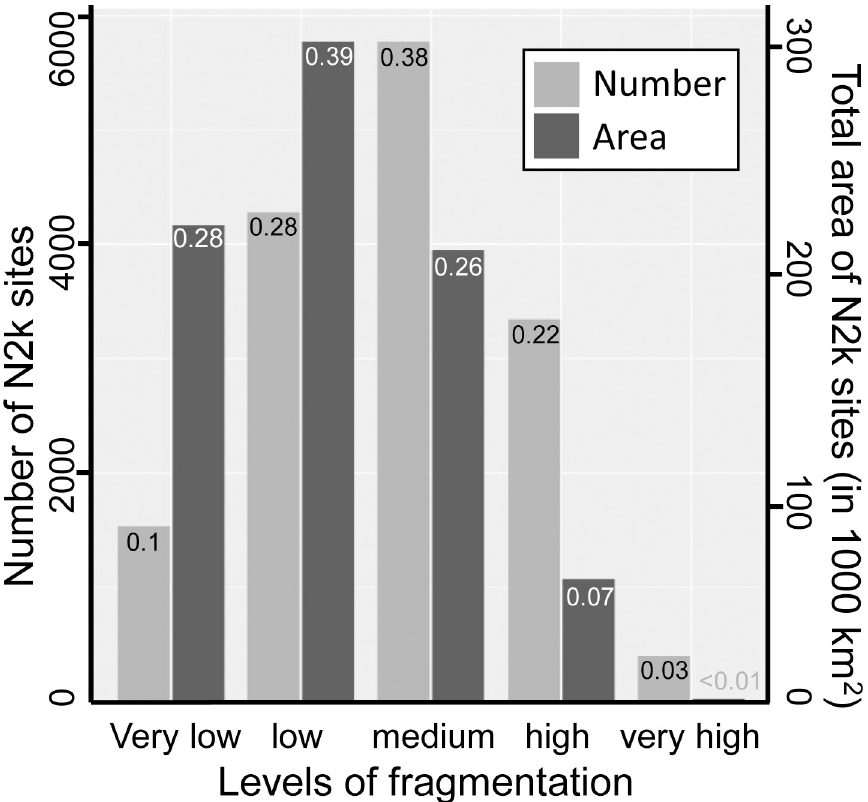
Fig 6. Number and area coverage of N2k sites per fragmentation category. Bars in light grey represent absolute numbers of N2k sites analyzed in this study. Bars in dark grey represent absolute area coverage in 1000 km 2 of N2k sites analyzed in this study. Black decimal numbers represent the relative amount of sites for each of the five fragmentation categories. White decimal numbers represent the relative amount of area covered by N2k sites for each of the five fragmentation categories. The total number of N2k sites analyzed was 15390 (55.3% of N2k sites). The total area covered by N2k sites analyzed was 796637 km 2 (79.5% of the total area covered by N2k sites). Fragmentation categories are based on EEA standards for effective mesh density (Table